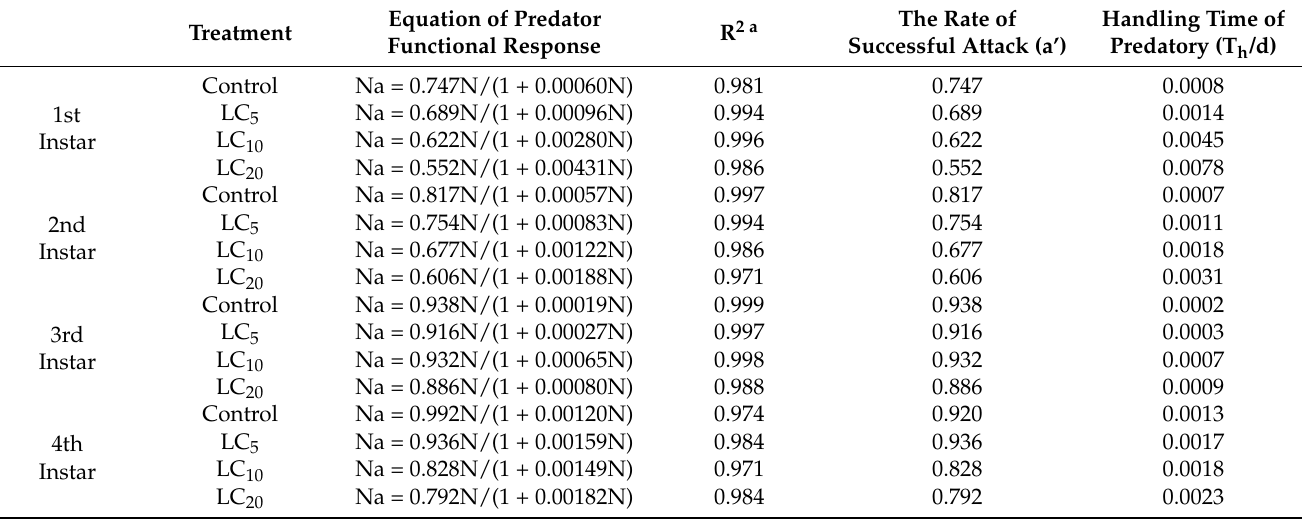
Table 3. Predatory functional response model and parameters of C. septempunctata in different larval stages.